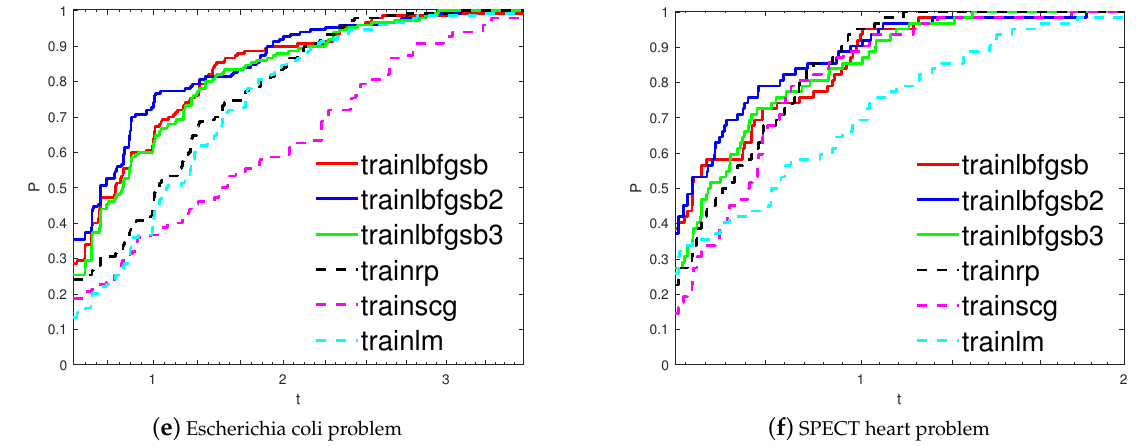
Figure 14. Log 10 scaled performance profiles based on F 1 -score of WCNN against the state-of-the-art training algorithms R PROP , SCG and